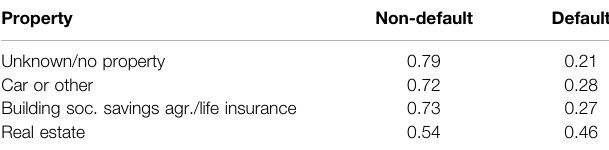
TABLE 4 | Default rates of the variable property on the training data. Property